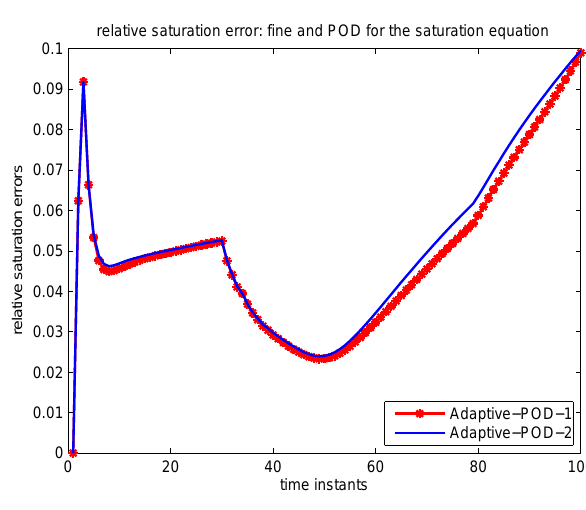
relative saturation error: fine and POD for the saturation equation